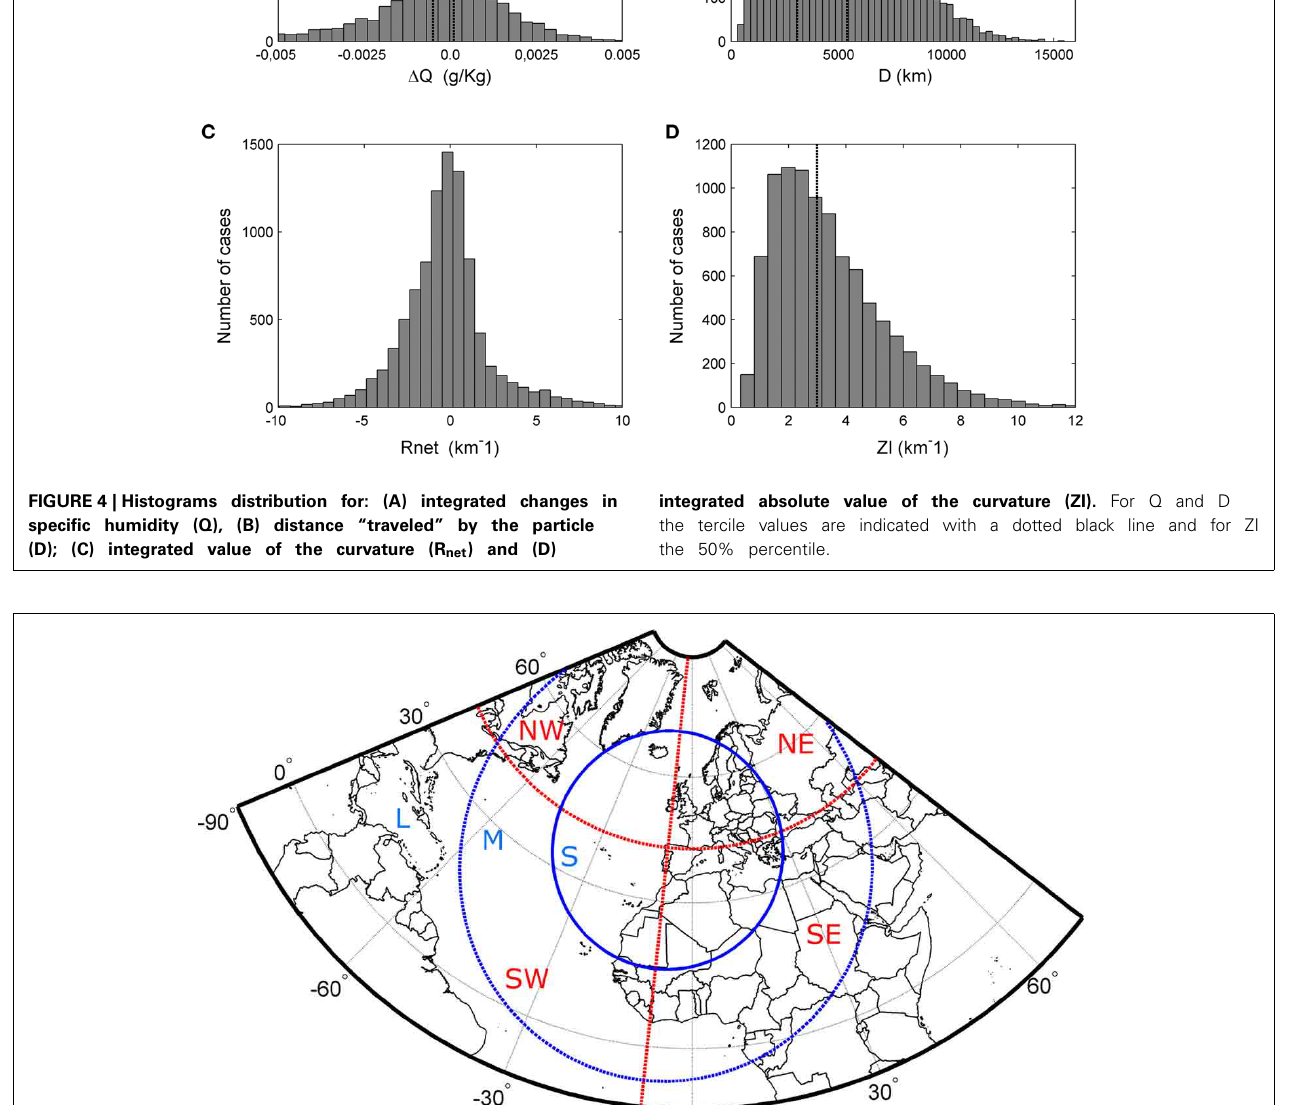
FIGURE 5 | Definition for the Distance and Origin (DO) characteristic for the air streams. The circles separate the different distance (D) classes: short range (S), medium range (M), and long range (L).The origin of the air streams is split into the four regions SW, NW, SE, and NE. In total, 12 classes result for DO.